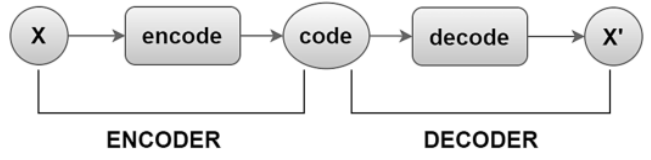
Figure 1. Components of the